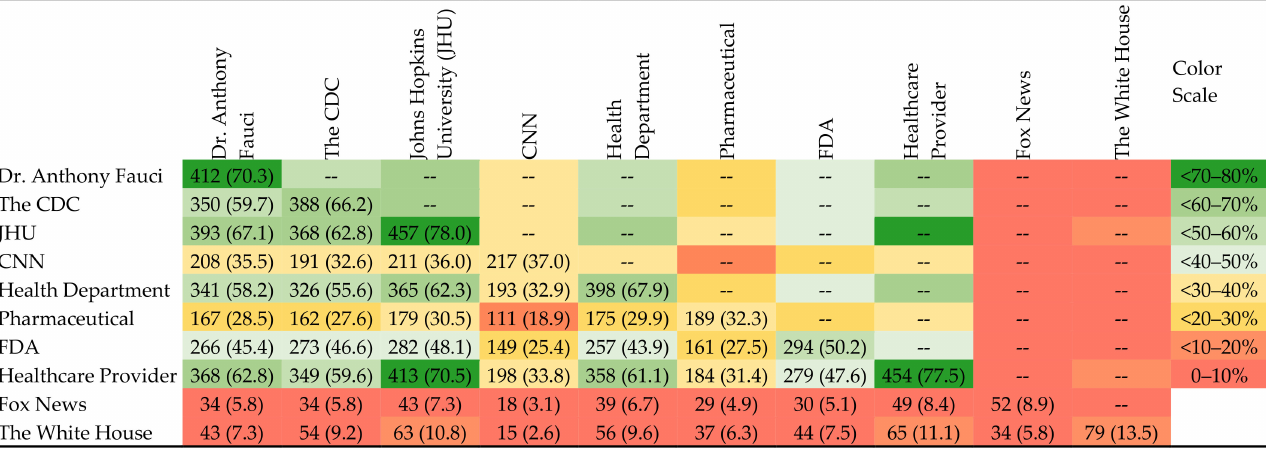
Figure 1. Concordance among high trust ratings of 10 sources of COVID-19 vaccine information among study participants in the US, 2020, N